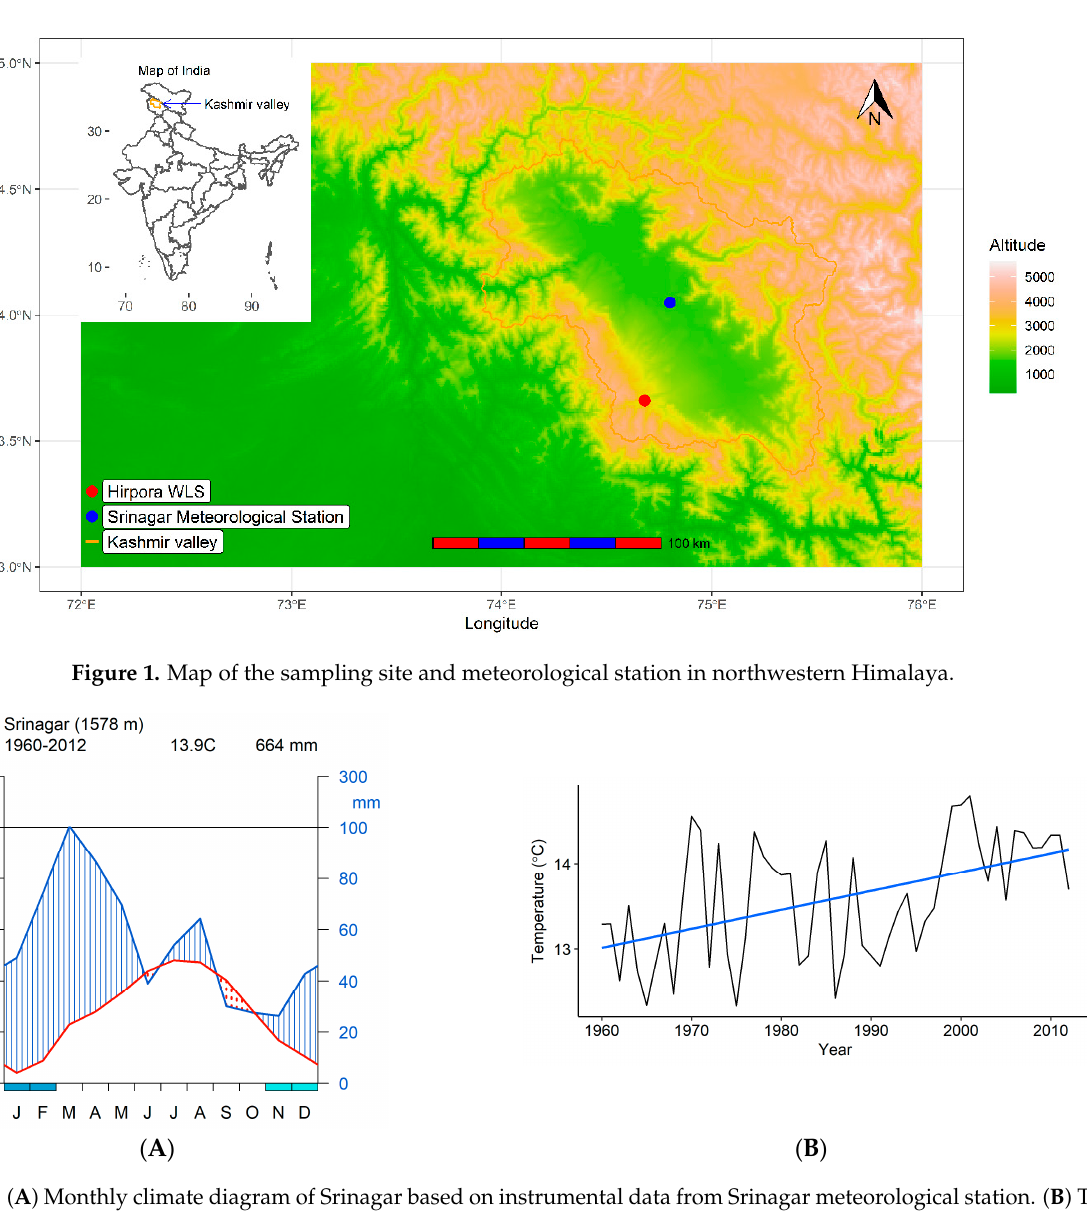
Table 1. Descriptive statistics of site chronology. Time Span